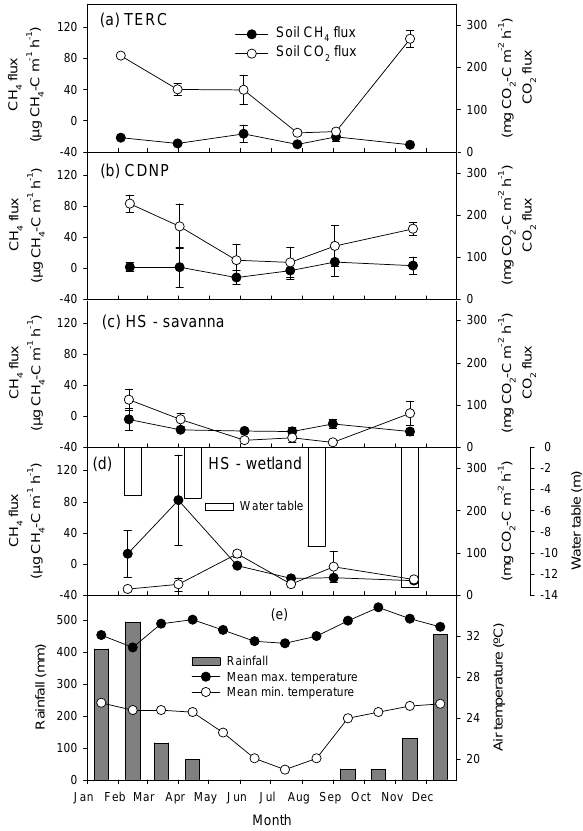
Fig. 2. Mean soil fluxes ( n = 5) of CH 4 and CO 2 measured at four different sites; error bars are standard error of the mean; panel (e) shows the climate data of 2009 from the Darwin Airport meteoro- logical station of the Bureau of Meteorology,